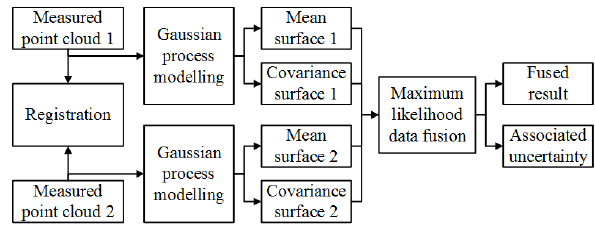
Figure 1. Framework of the Gaussian process and maximum likelihood ‐ based data fusion method.